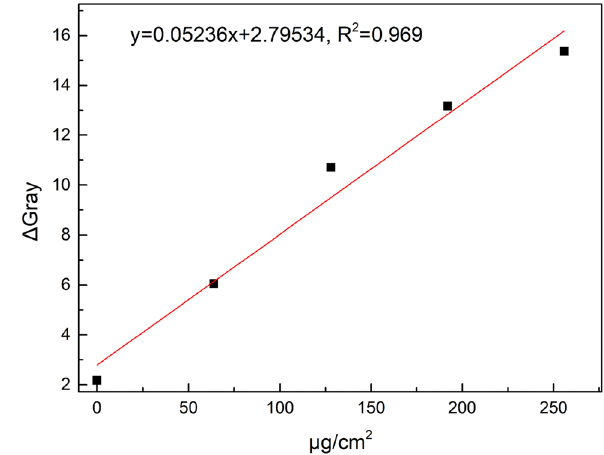
Figure 7: The e ff ect of elution time on color development.